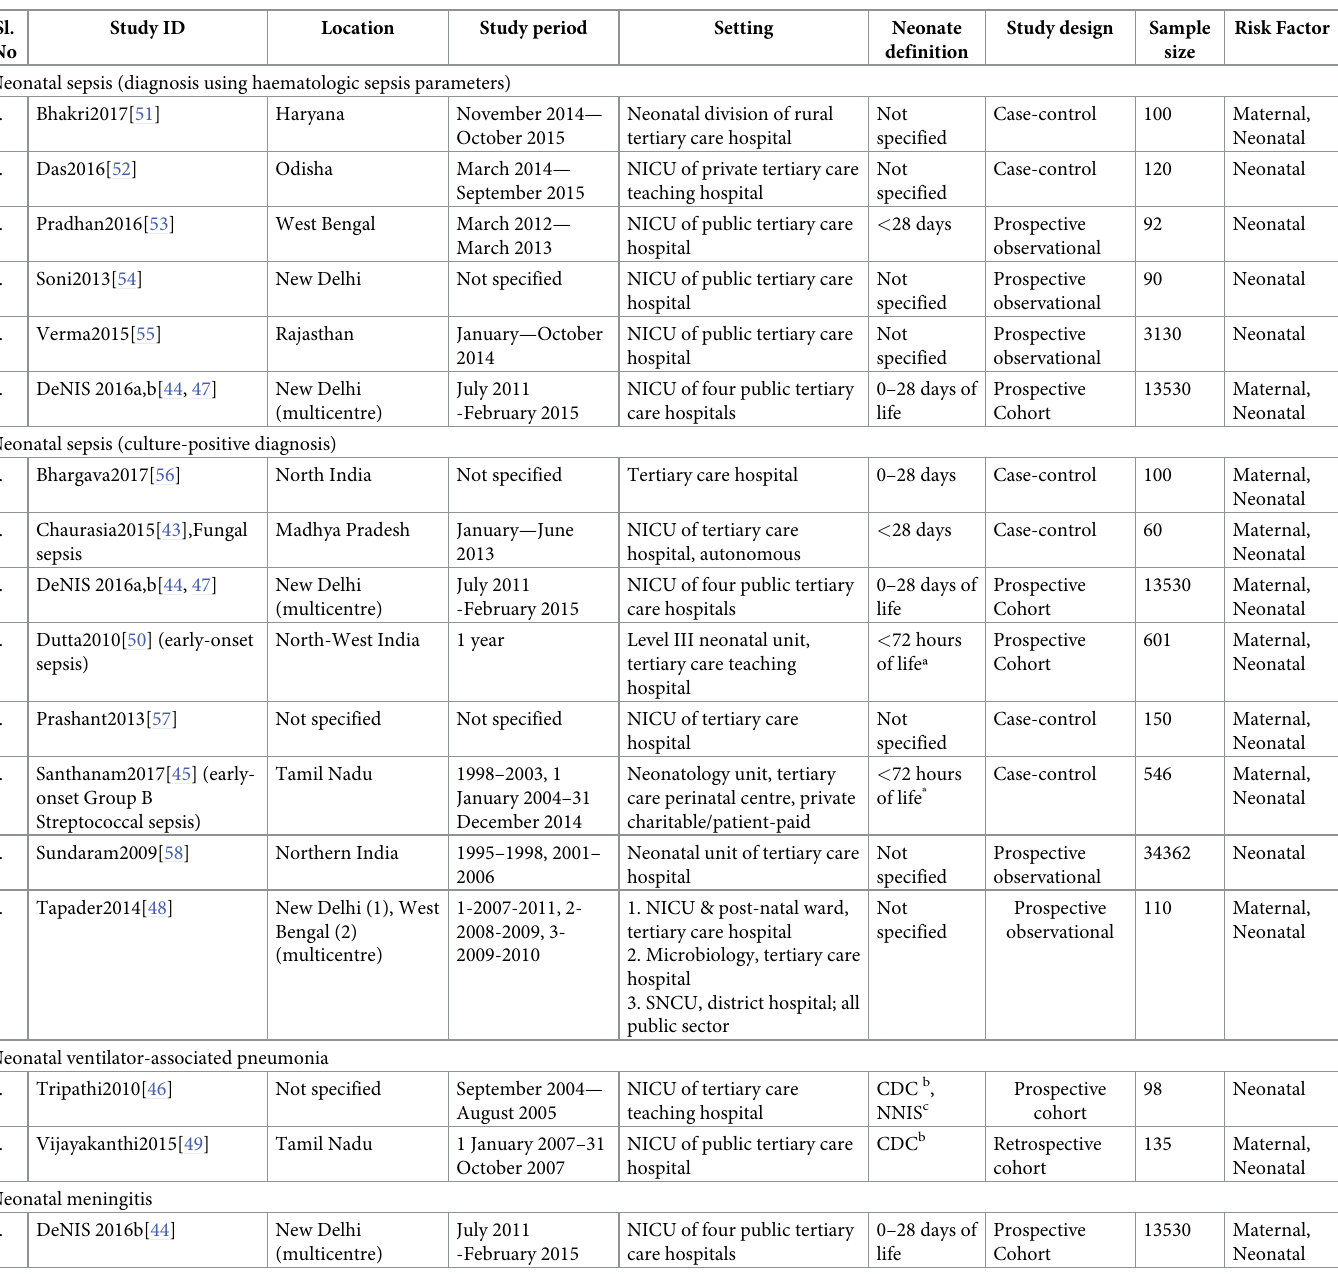
Table 1. Characteristics of included